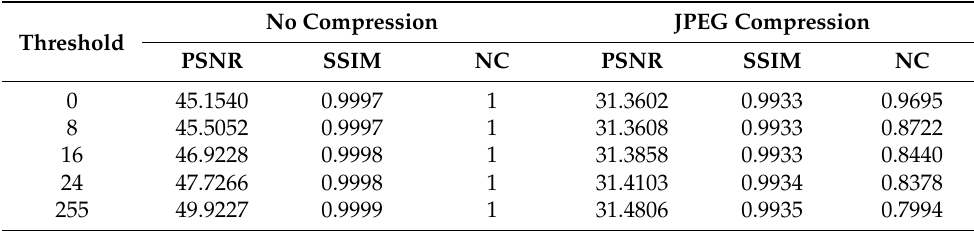
Table 1. Watermarking results using different